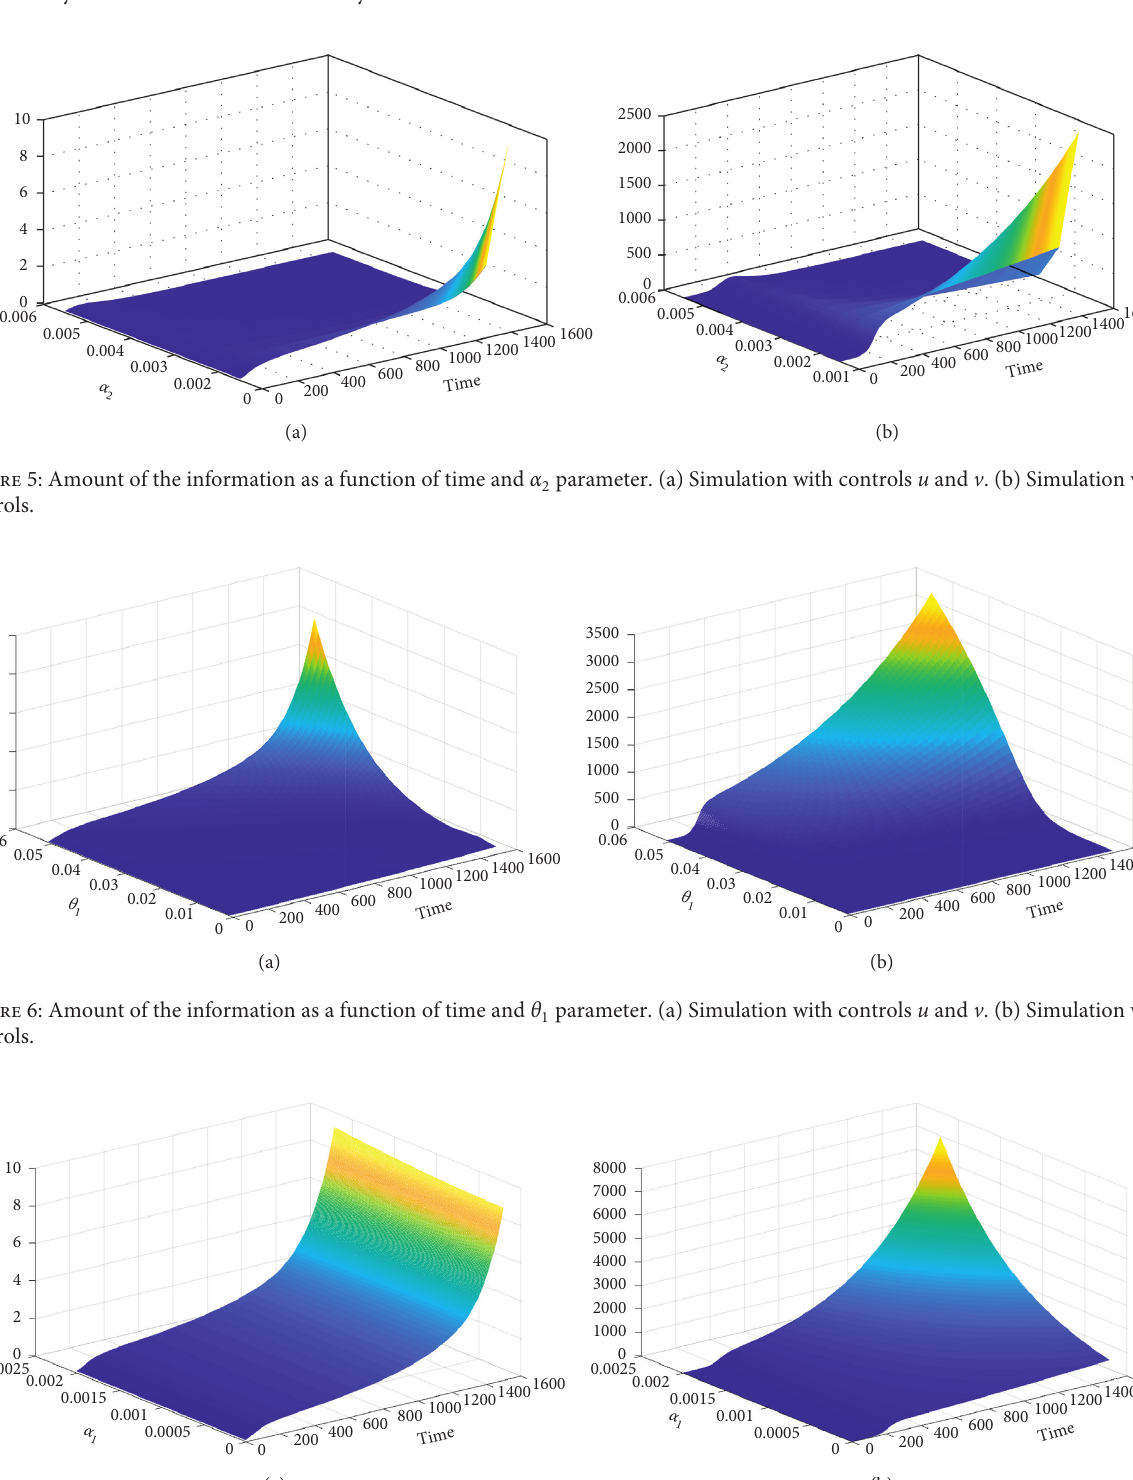
parameter. (a) Simulation with controls u and v . (b) Simulation without 1